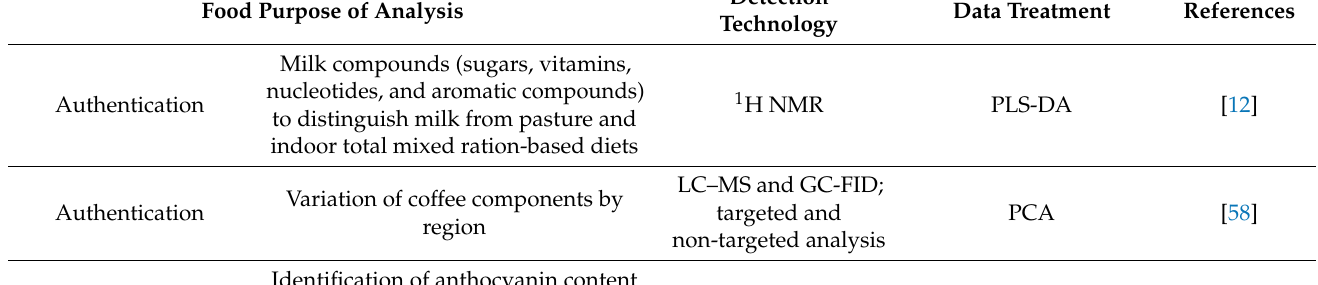
Table 2. Examples of metabolomic approach (authentication, quality, and nutritional) in foods. Food Purpose of